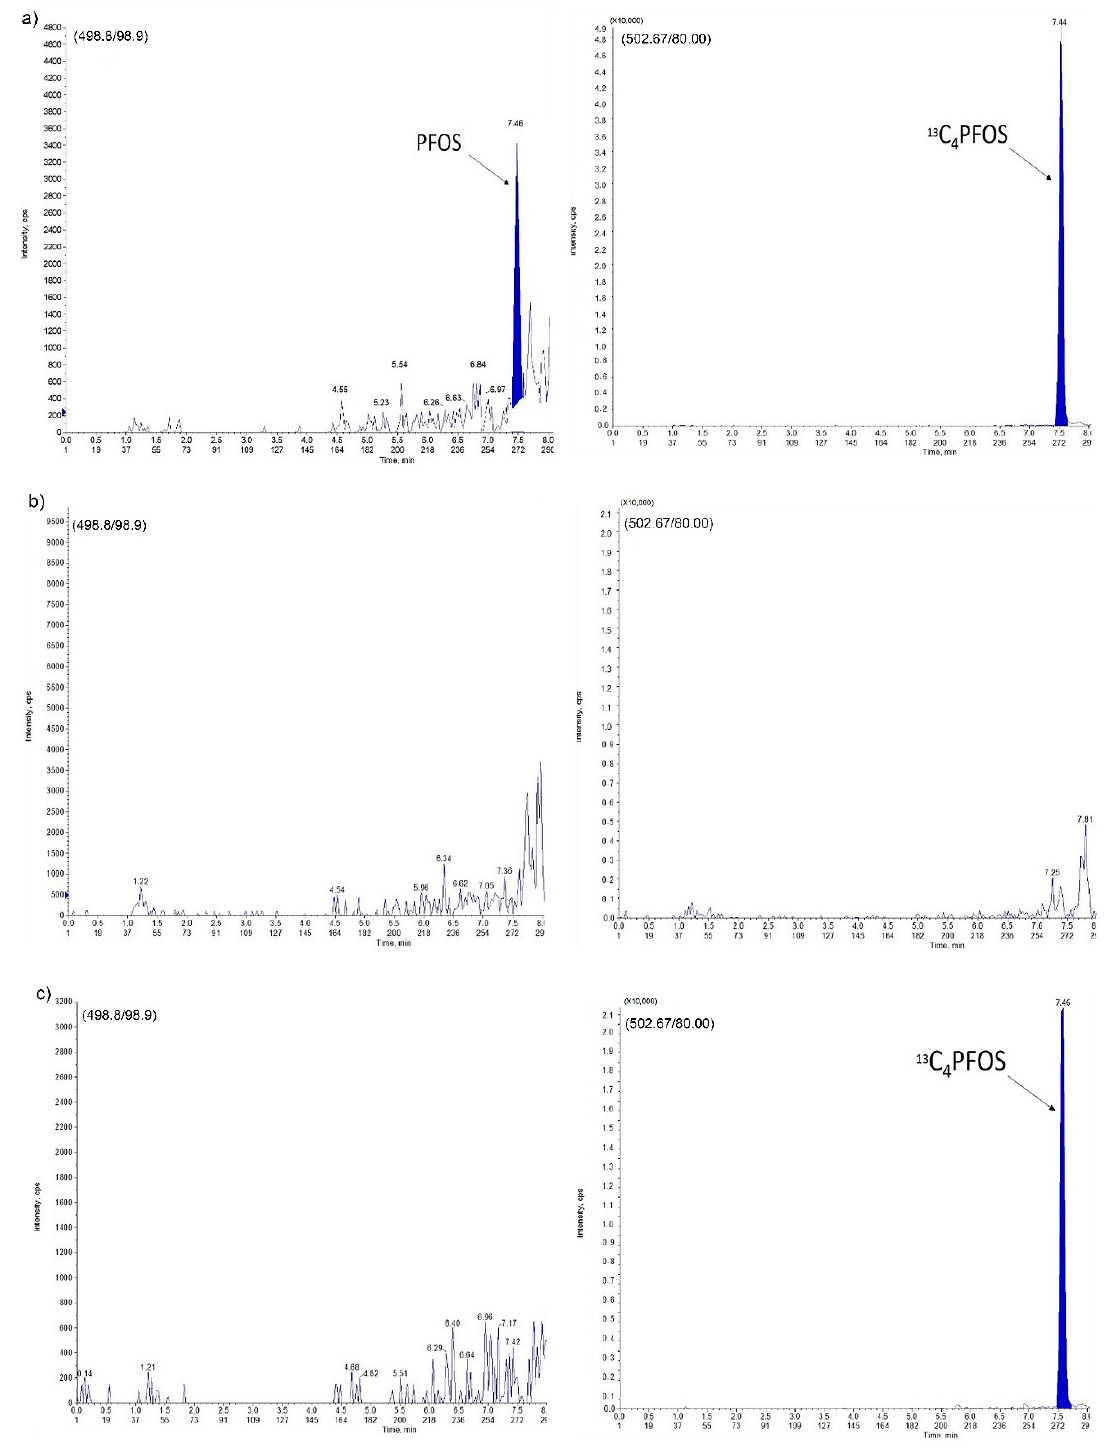
Figure 3. Perfluorooctane Sulfonate (PFOS) in egg yolk sample: ( a ) LLOQ; ( b ) double blank sample; ( c ) zero blank sample.